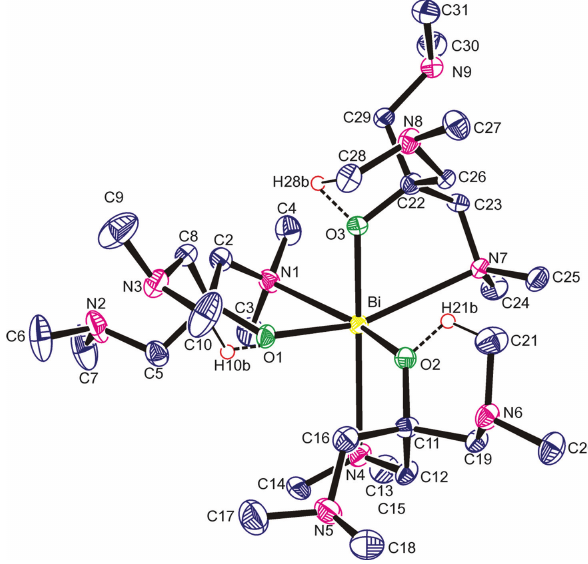
Figure 1 The asymmetric unit of 1 showing the labeling scheme used; thermal ellipsoids are at the 40% probability level.